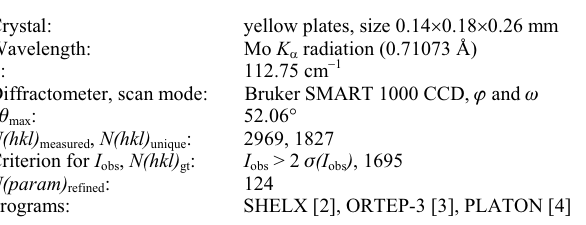
Table 1. Data collection and handling.